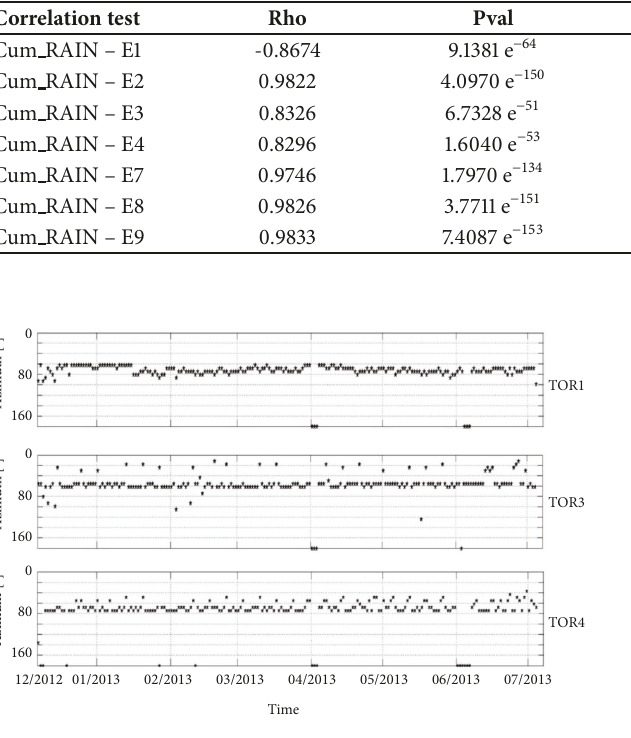
Figure 8: The peak azimuth distribution at TOR1, TOR3, and TOR4 over the whole monitoring